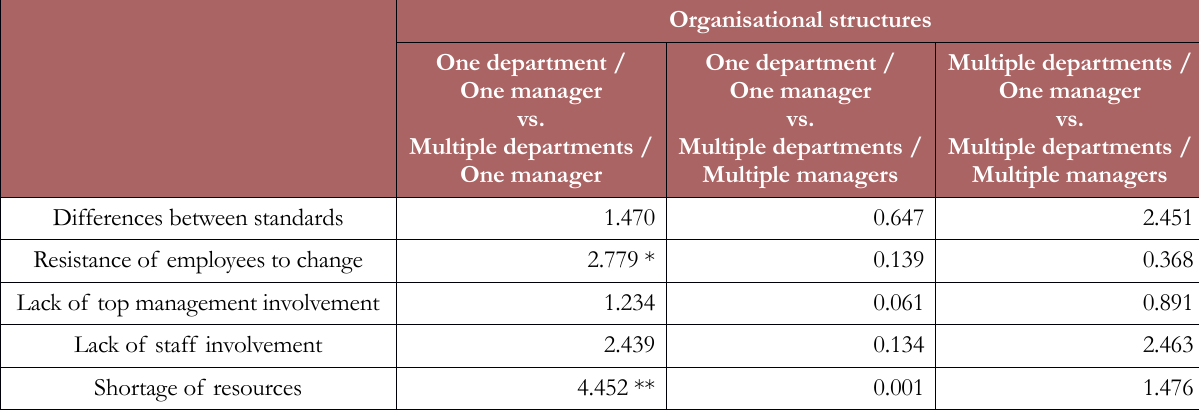
Table 4. Kruskal-Wallis test: Difficulties according to the organisational structure of the